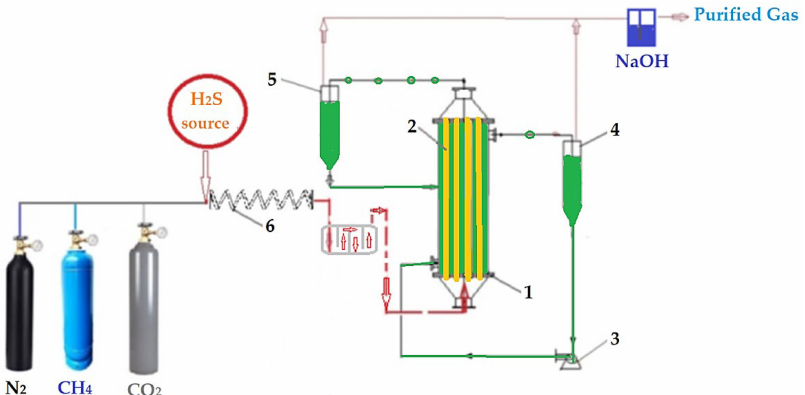
Figure 3. Schematic presentation of the laboratory installation for hydrogen sulfide sequestration from a gaseous mixture: 1—membrane contactor; 2—composite hollow fiber membranes; 3—pump for metal ions acidic solutions; 4 and 5—gas-liquid separator;